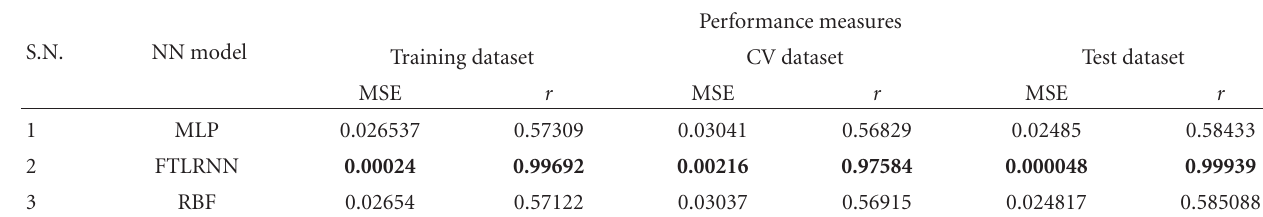
Table 15: Regression performance of NN models on EMG signal.